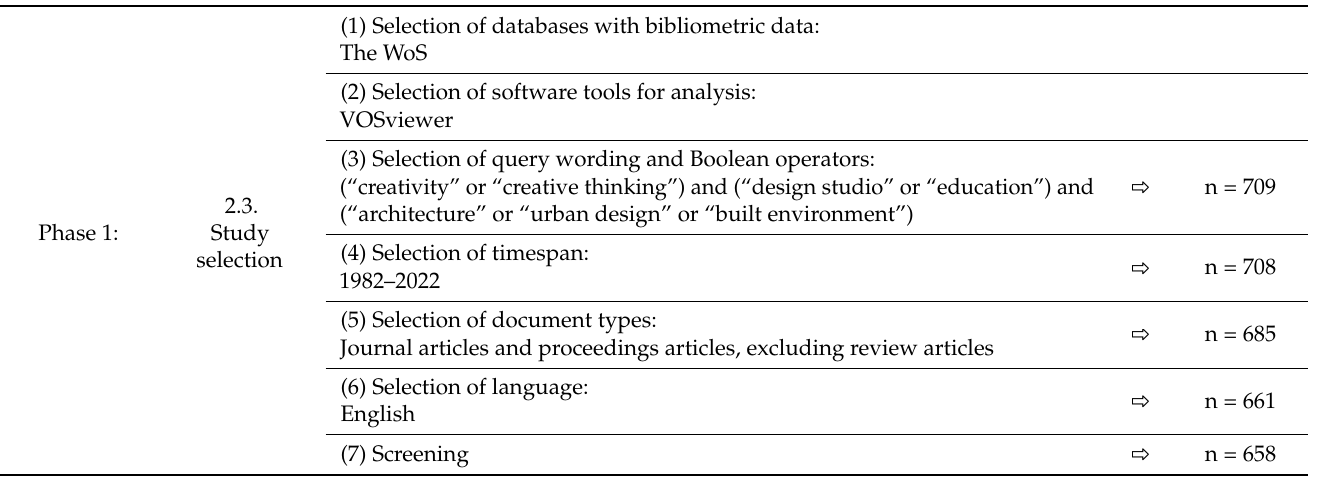
Table 1. Flowchart summarizing study